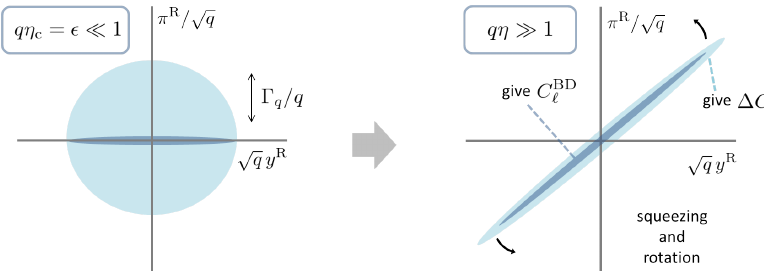
Figure 5. For the super-horizon mode, the Wigner function is squeezed until the mode re-enters the horizon after